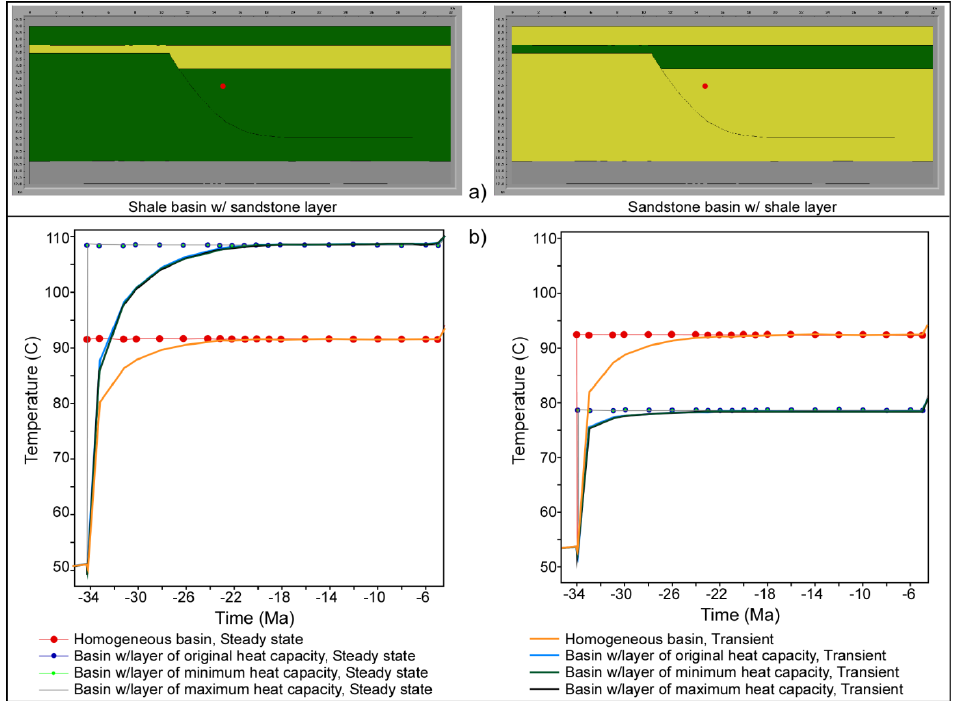
Figure 12. ( a ) Shale and sandstone basins with sandstone layer and shale layer respectively. The red point indicates location for point plot in ( b ). ( b ) Results show the temperatures for the three tested heat capacities for shale basin with one sandstone layer and sandstone basin with one shale layer. For 2. comparison, temperatures for homogeneous basin are also plotted. For heat capacity values see Table